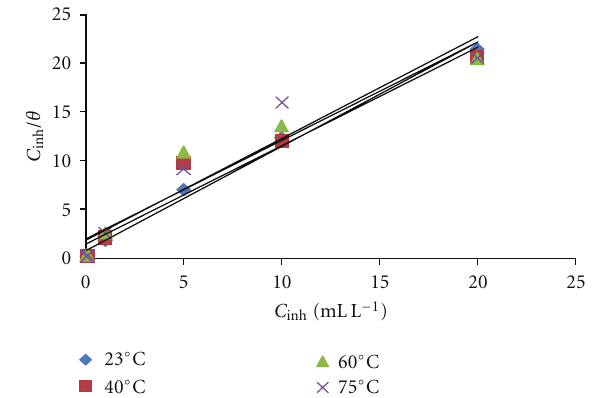
Figure 2: Langmuir adsorpti on isotherm of EEPD on carbon